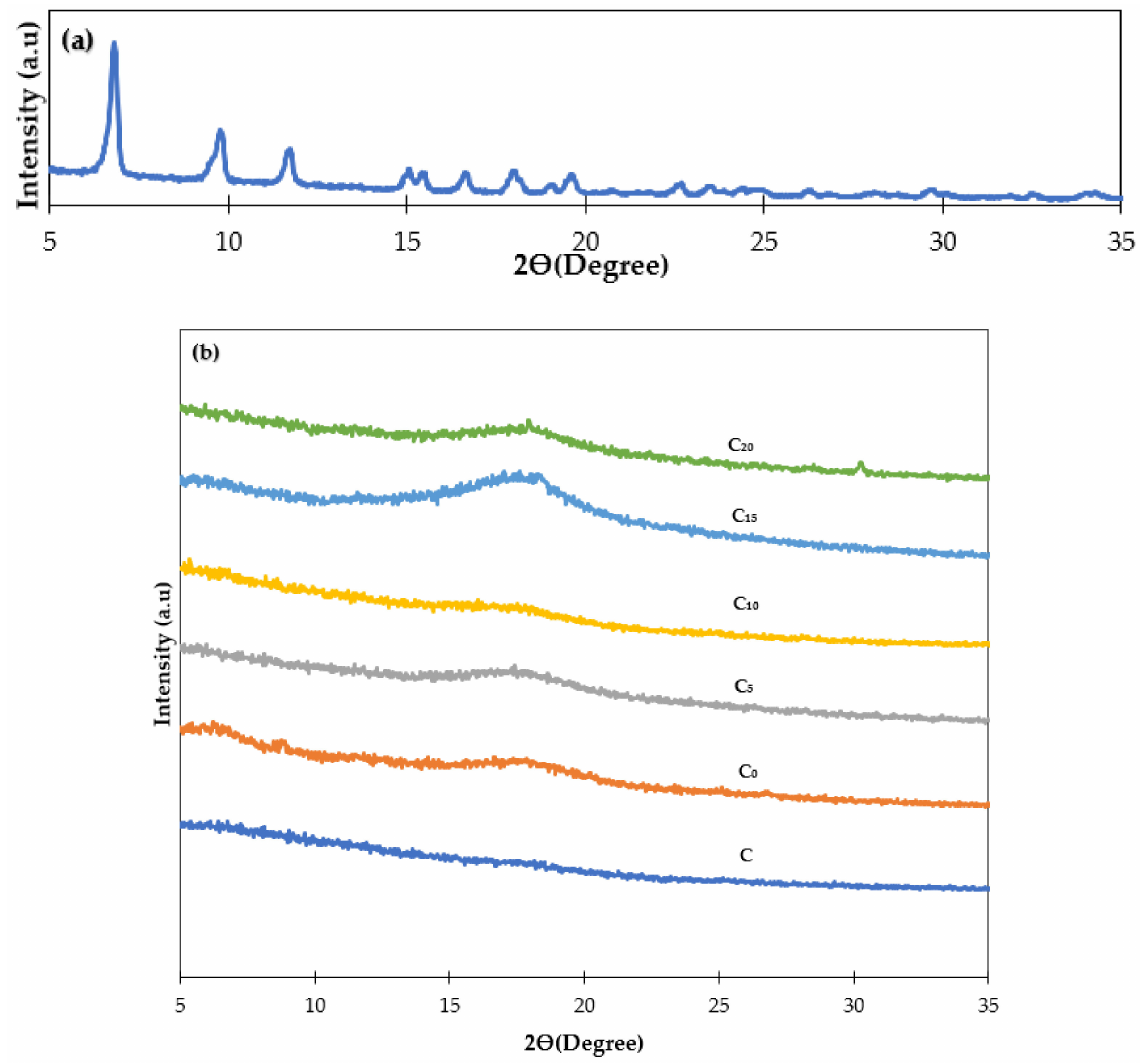
Figure 2. XRD patterns of ( a ) NH 2 -MIL-125(Ti) and ( b ) composite